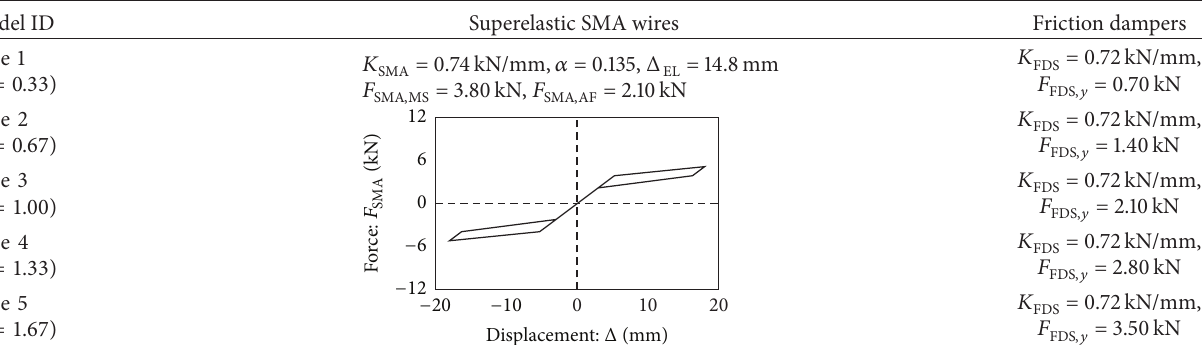
Table 1: Parametric details for individual model